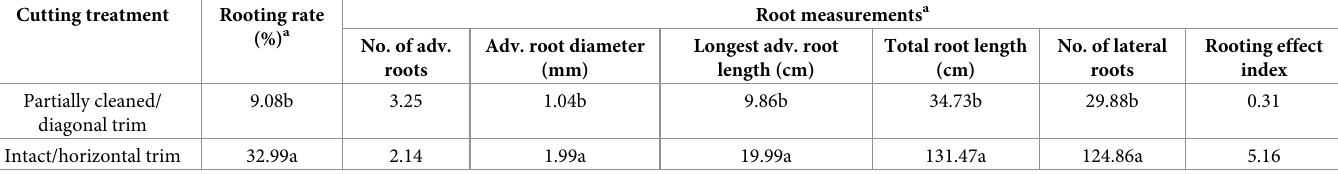
Table 4. Effect of cutting treatments on the rooting rate and other root related traits of PWD resistant stem cuttings. Cutting treatment